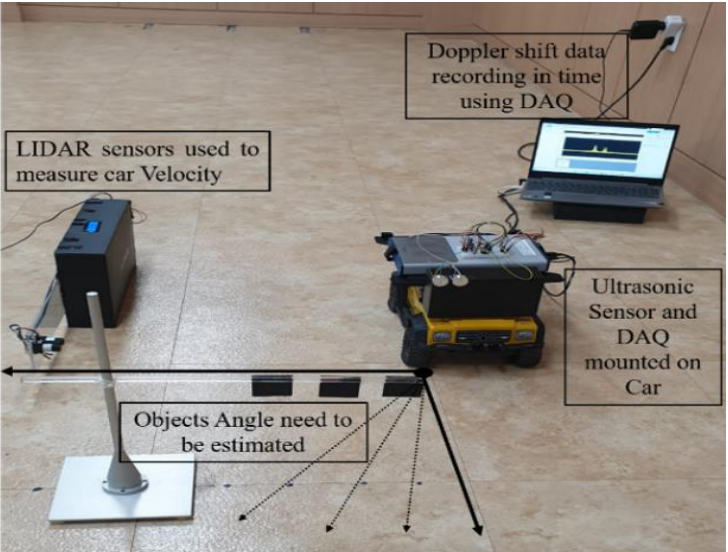
Figure 7. Complete experimental setup of the experiment measuring azimuthal angle through Doppler shift.